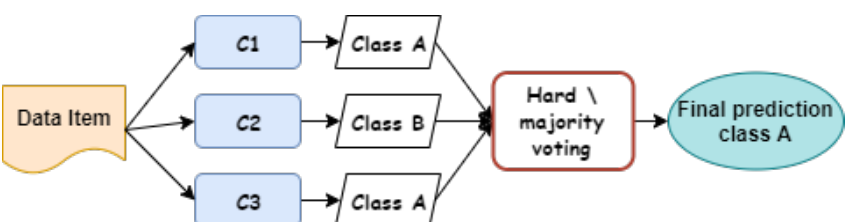
Figure 2. Hard ensemble voting